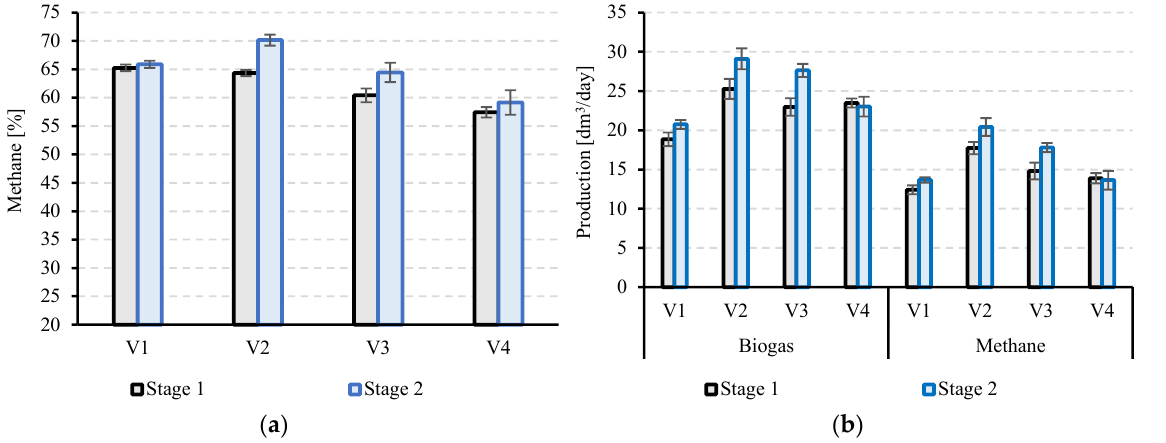
Figure 3. CH 4 content of biogas ( a ) and average daily biogas and CH 4 production in particular experimental variants ( b ).